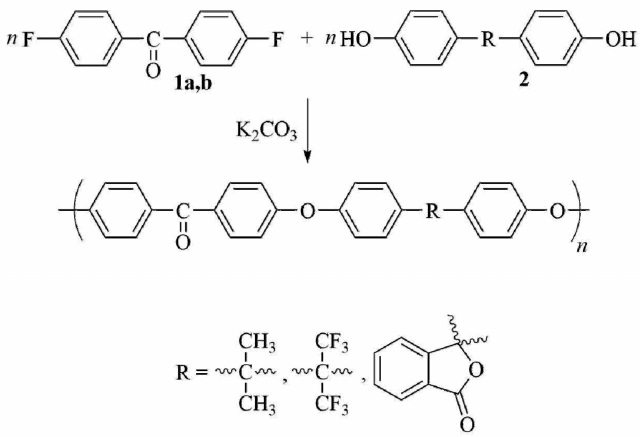
Figure 1. PAEKs C1–C3 synthesis scheme.